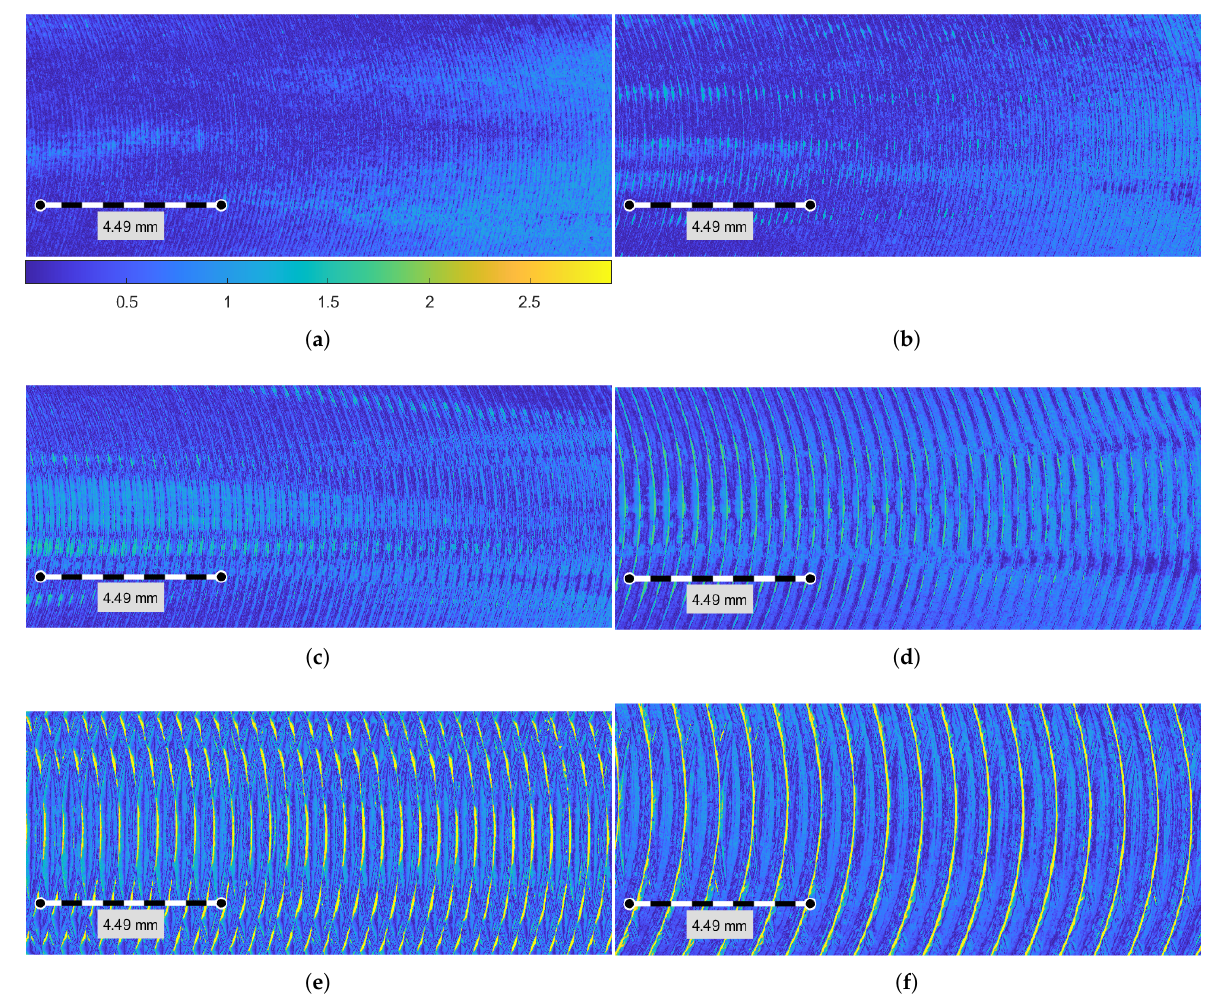
Figure 14. Mahalanobis distance map calculated with the descriptor of the geometrics descriptors between the surfaces taken from the set Rubert n ◦ 130: ( a ) Mahal ∗ ( R 1, R 1 ) ; ( b ) Mahal ∗ ( R 2, R 1 ) ; ( c ) Mahal ∗ ( R 3, R 1 ) ; ( d ) Mahal ∗ ( R 4, R 1 ) ; ( e ) Mahal ∗ ( R 5, R 1 ) ; ( f ) Mahal ∗ ( R 6, R 1 )